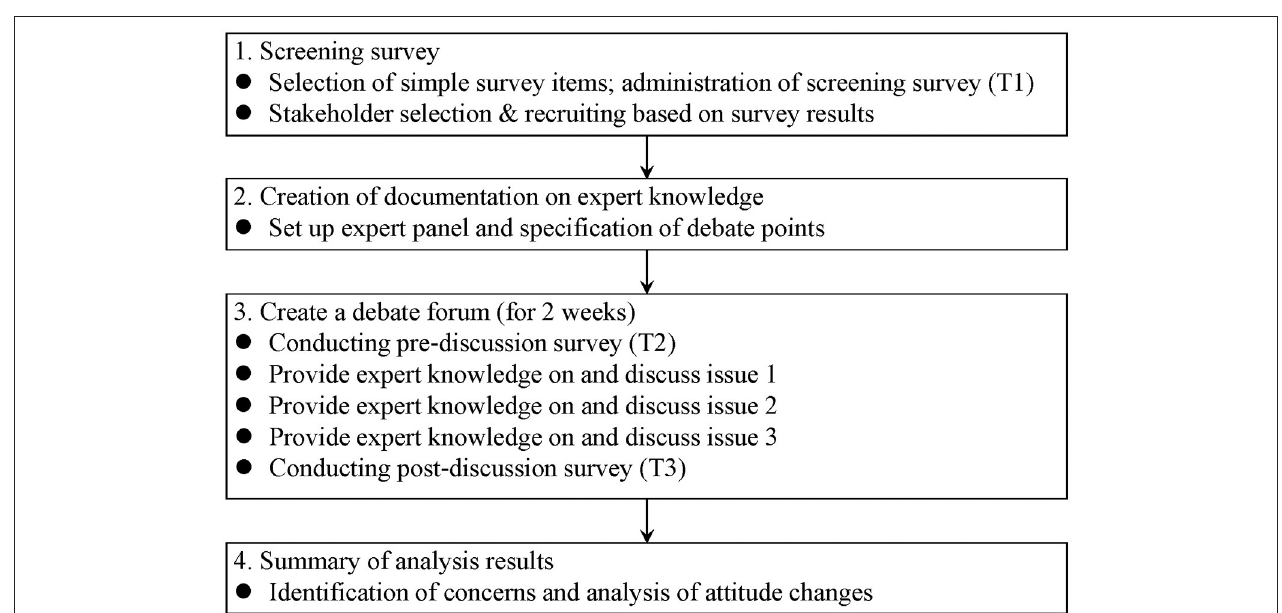
FIGURE 1 | Experiment process of online deliberation.